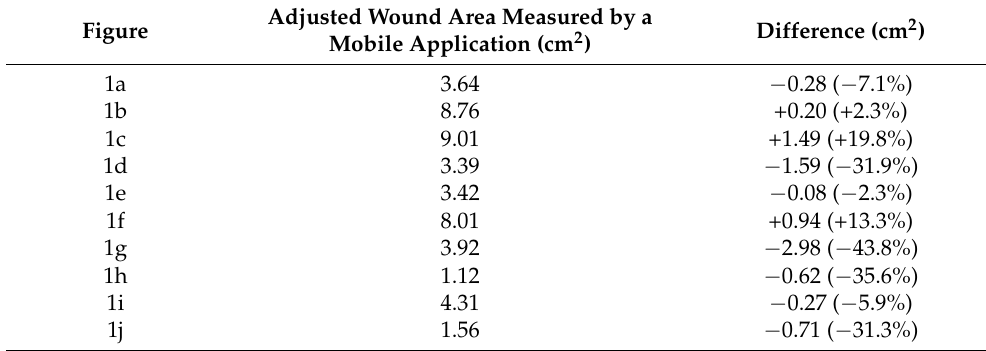
Table 6. Adjusted wound area measured by a mobile application and the final errors reported. Adjusted Wound Area Measured by Figure